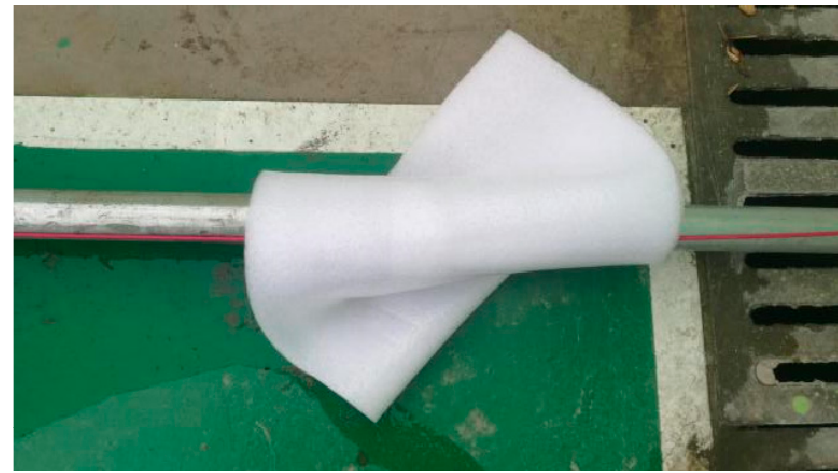
Figure 6. Steel pipe is covered with thermal insulation foam.